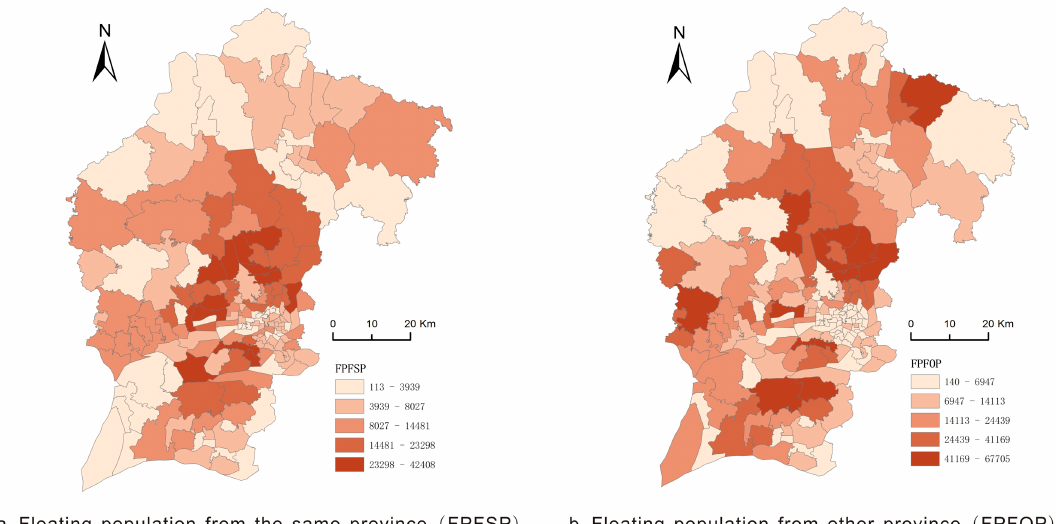
Figure 1. Distribution of floating population.